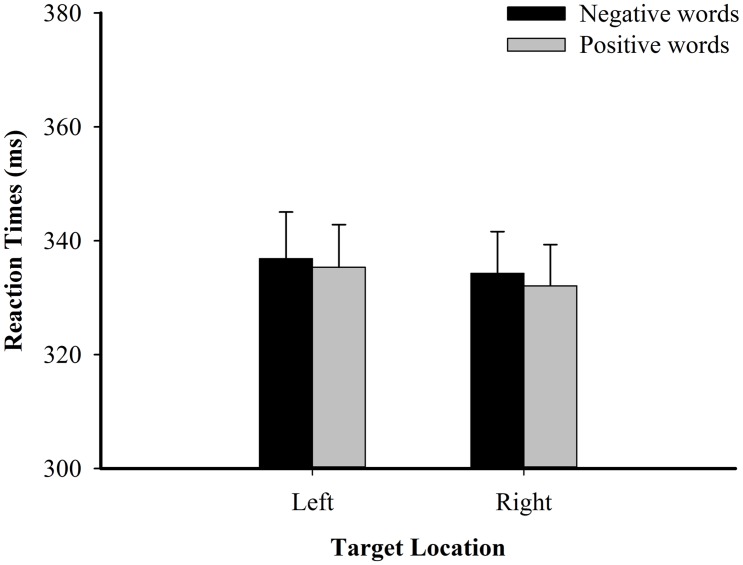
Spatial target detection RT (in ms) in Experiment 1A.